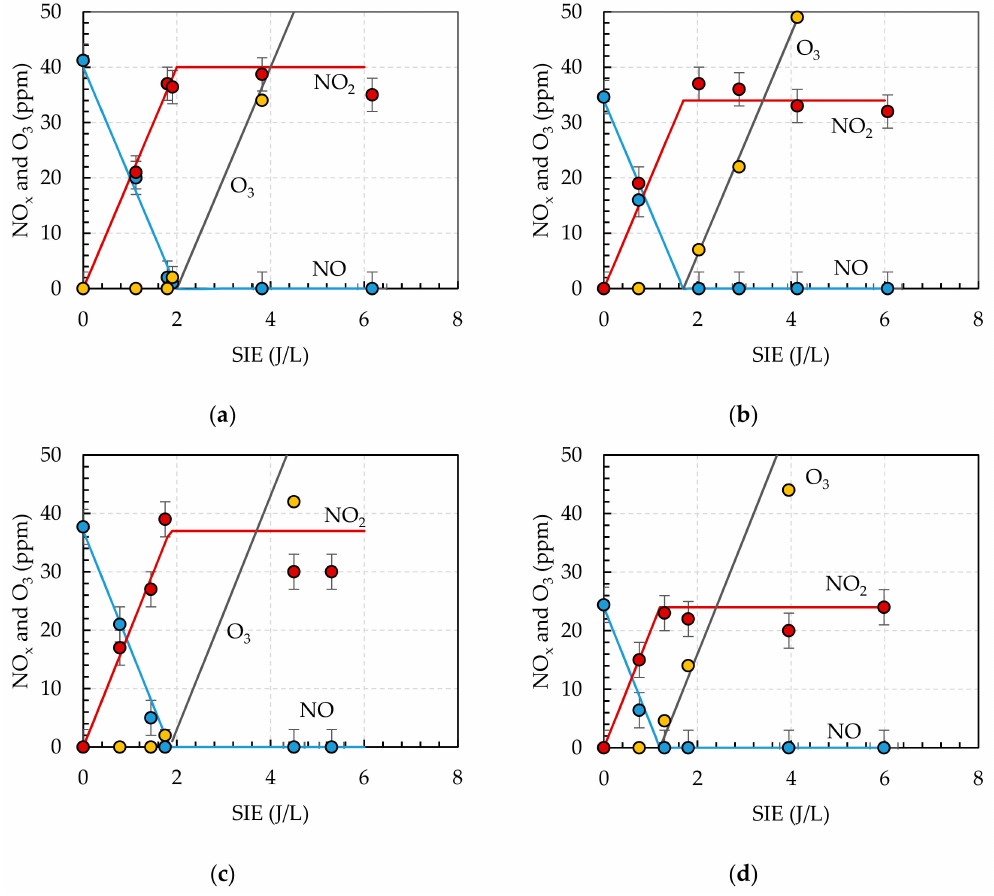
Figure 6. The concentrations of NO, NO 2 and O 3 as a function of specific input energy (SIE) by ozone injection at ER ( a ) 0.8; ( b ) 1.0; ( c ) 1.2; ( d ) 1.4 value (Lines show theoretical